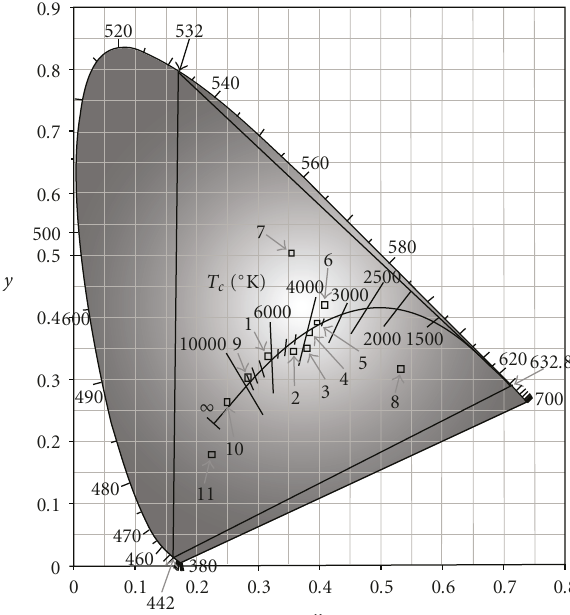
Figure 8: Diagram of color coordinates and color temperatures of real objects (1) white surface, (2) snow, (3) white human skin, (4) grey stone, (5) sand, (6) yellow flower, (7) green grass, (8) red flower, (9) blue sky, (10) lake on a sunny day, (11) blue flower.